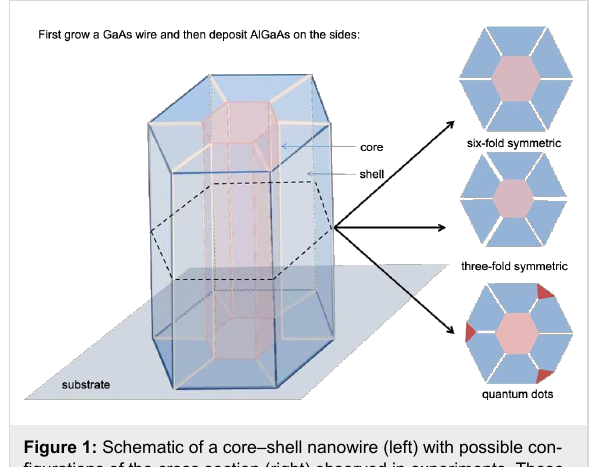
Figure 1: Schematic of a core–shell nanowire (left) with possible con- figurations of the cross section (right) observed in experiments. These are the six-fold symmetry configuration observed in [3] with Al-rich {112} facets along the corners of the hexagonal core (top right); the three-fold symmetry configuration observed in [4] (middle right) and the Al-poor quantum dots (red) at the apices adjunct with the Al-rich stripes observed in [2] (bottom right).